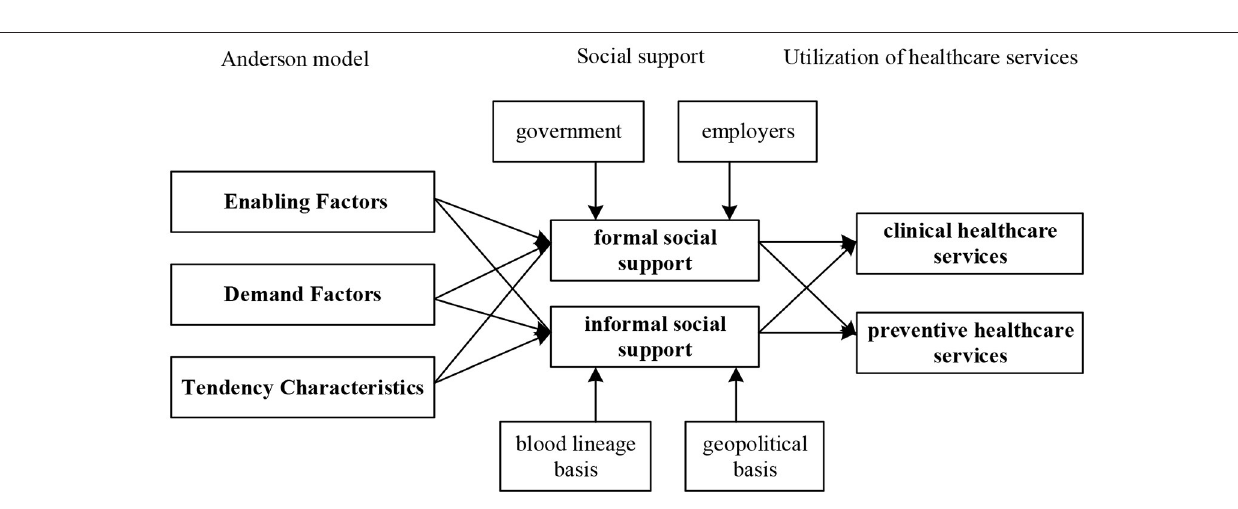
FIGURE 2 | Research